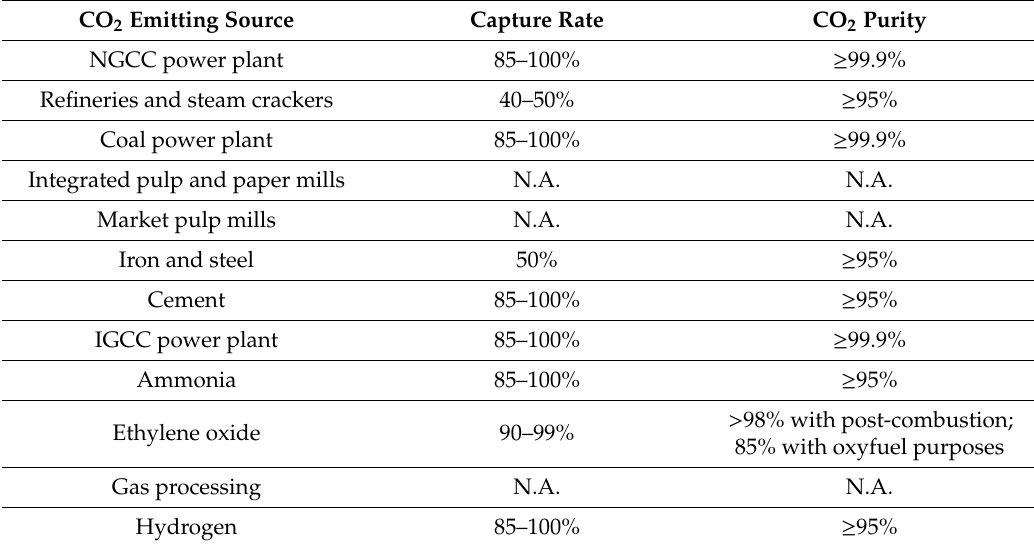
Table 1. Potential CO 2 from point sources, with capture rate and captured CO 2 purity. IGCC = Integrated Gasification Combined Cycle; NGCC = Natural Gas Combined Cycle. Data from